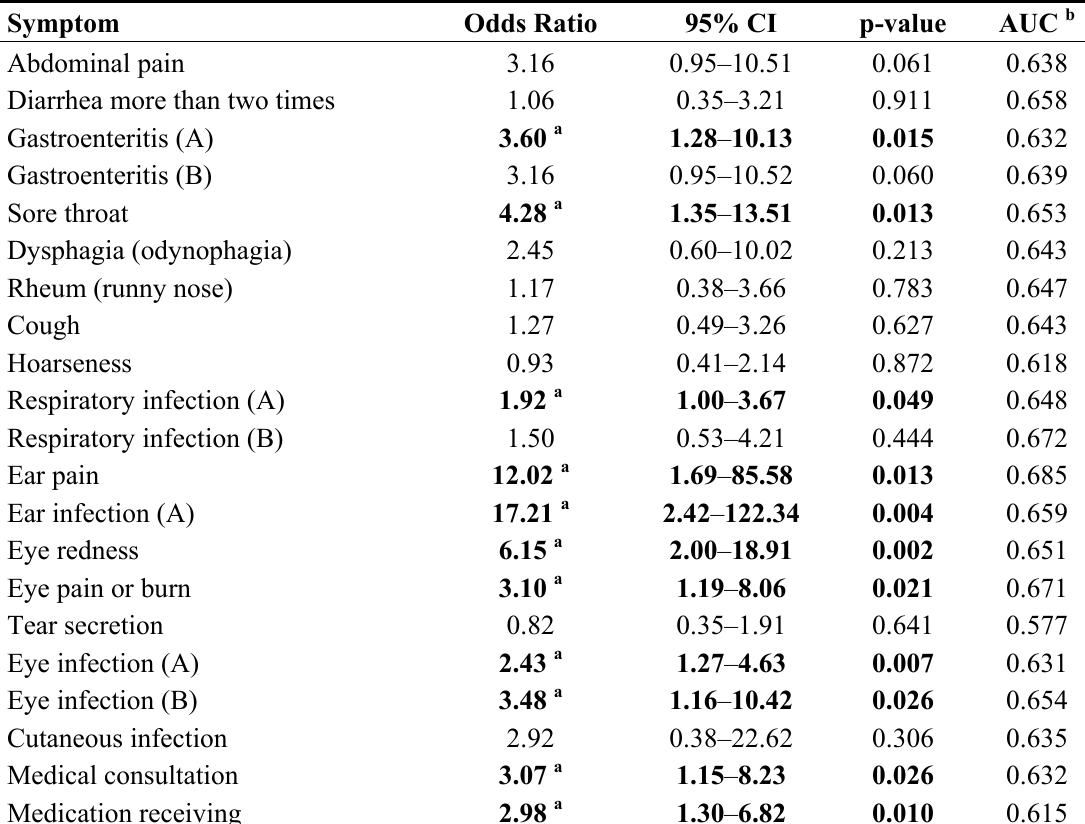
Table 4. Association of symptoms and related infections among bathers and non-bathers (multivariable